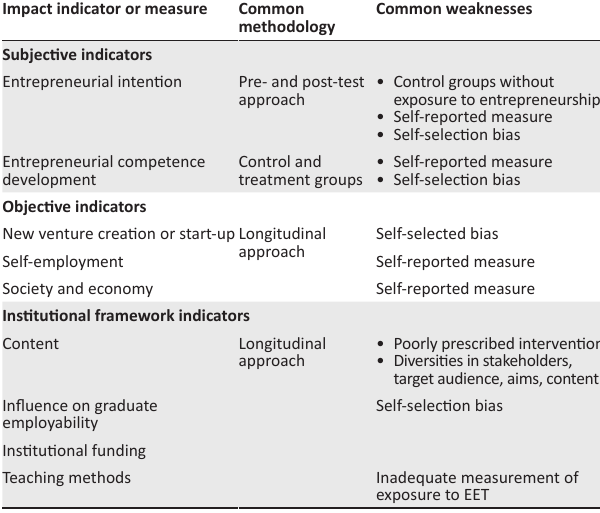
TABLE 3: Common methodology and weaknesses in entrepreneurship education and training impact